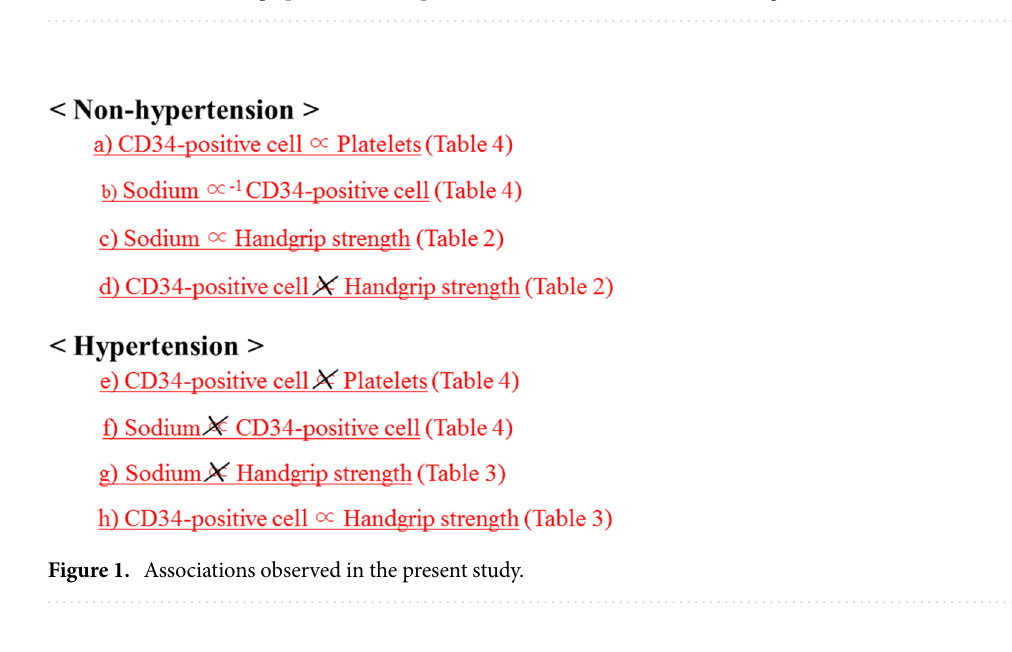
Table 4. Simple correlation analysis of circulating CD34-positive cell with relevant factors. r simple correlation coefficient, (p) p value. CD34-positive cell levels were calculated as logarithm values.